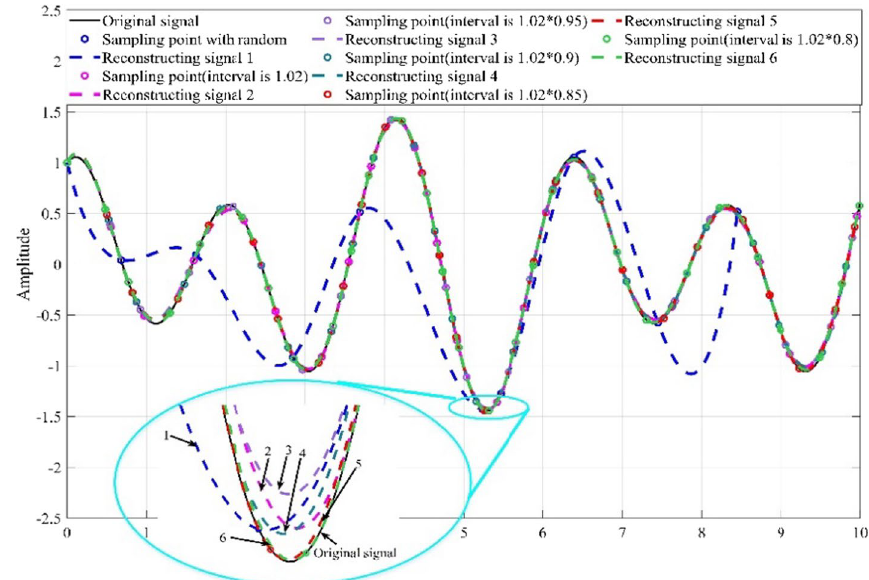
Fig. 8 Composite signal, random sampling points, sampling points with equal arc length (interval is 1.02, 1.02 0.95, 1.02 0.90, 1.02 0.85, 1.02 0.80) and reconstructing signals, × × × ×